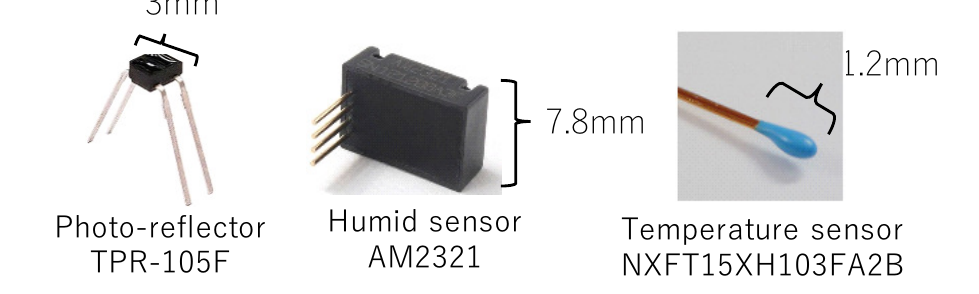
Figure 2. Sensors used in the pre-experiment.